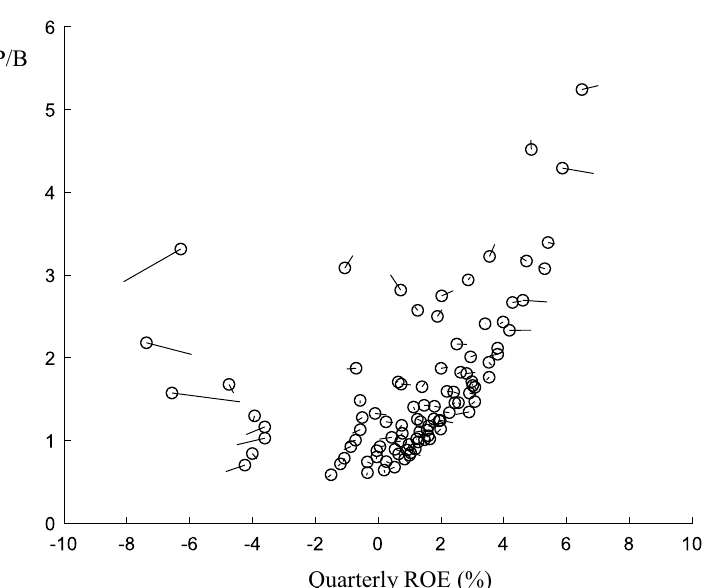
Fig. 6 The ROE and P/B ratio for the subsequent second and third quarter after the portfolios are formed